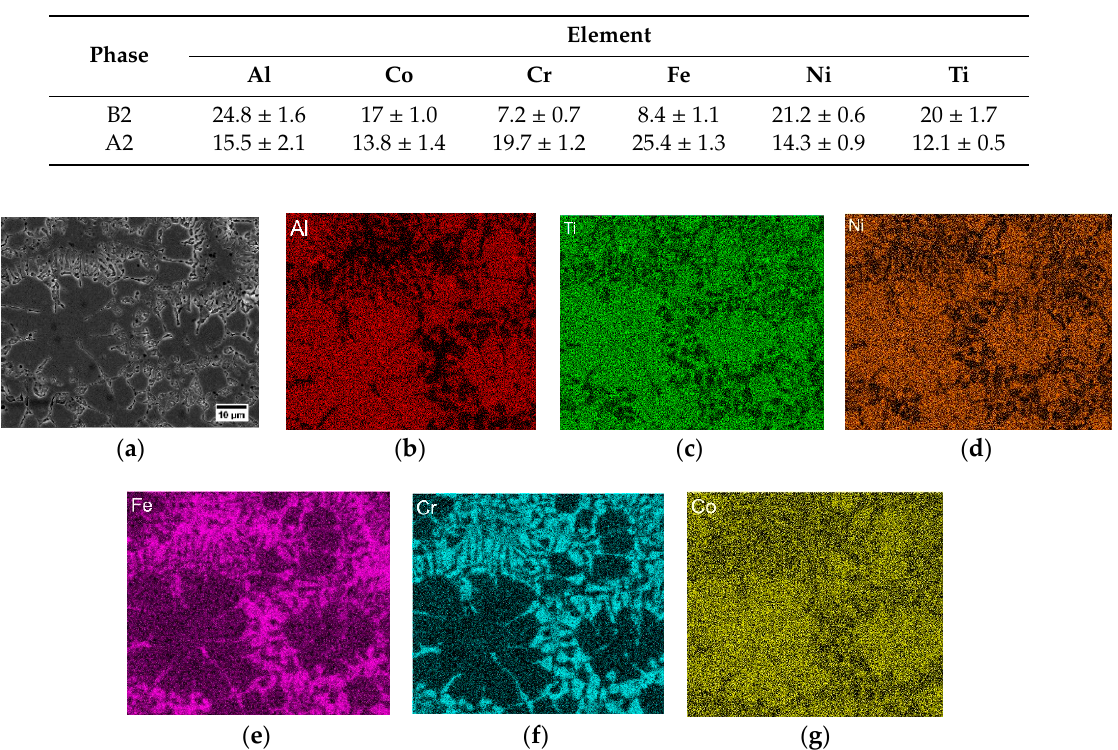
Figure 4. ( a ) Secondary electron image and the corresponding elemental maps of ( b ) Al, ( c ) Ti, ( d ) Ni, ( e ) Fe, ( f ) Cr, and ( g ) Co of the AlCoCrFeNiTi 0.5 HEA. The chemical mixing enthalpies of element pairs in AlCoCrFeNiTi 0.5 alloy are tabulated in Table 3. Table 2. Elemental composition (atom %) of each phase in the HEA by SEM-EDS (more than 5 The phase formation and element segregation are determined by the mixing enthalpy among the locations). constituent metallic elements. It is shown that Al, Ni, and Co has high negative mixing enthalpy with Ti, and they are liable to generate the B2 phase. For example, the mixing enthalpy between Al-Ti, Al-Ni, and Al-Co are − 30 kJ / mol, − 22 kJ / mol, and − 19 kJ / mol, respectively. Furthermore, Cr and Fe tend to form the A2 phase as they exhibit low mixing enthalpy close to zero. Table 3. The chemical mixing enthalpies of element pairs and atomic size [19,30]. Element